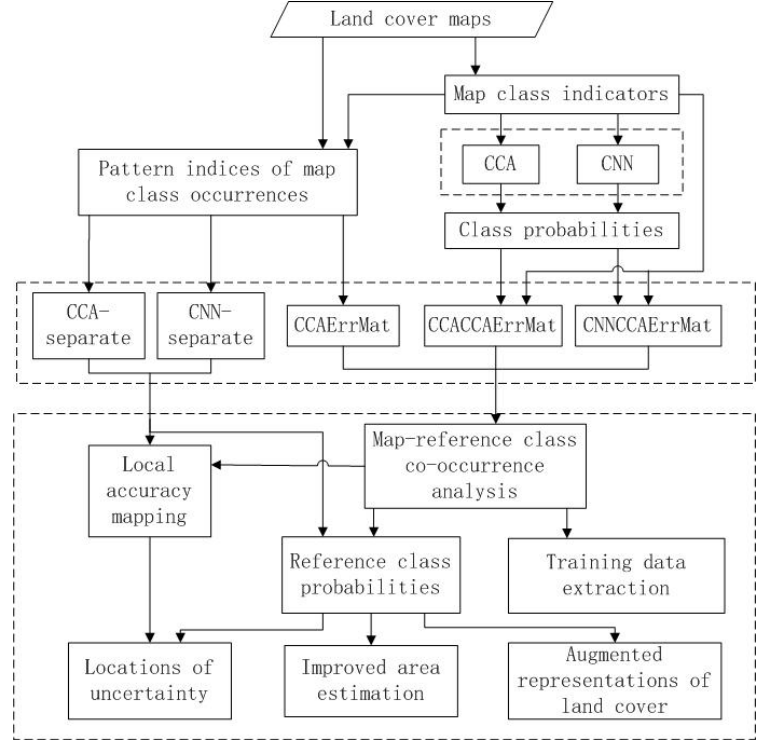
Figure 1. The flowchart showing the methods proposed in this research.